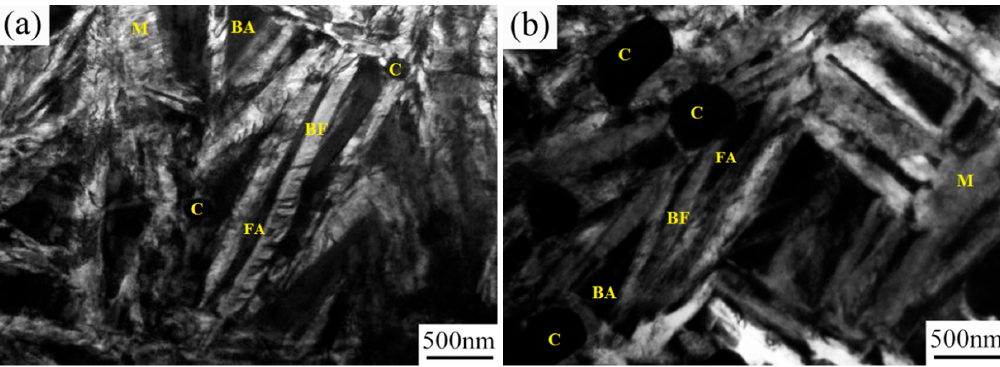
Figure 5. TEM micrographs of the surface of the specimen after heat treatment: ( a ) CC steel and ( b